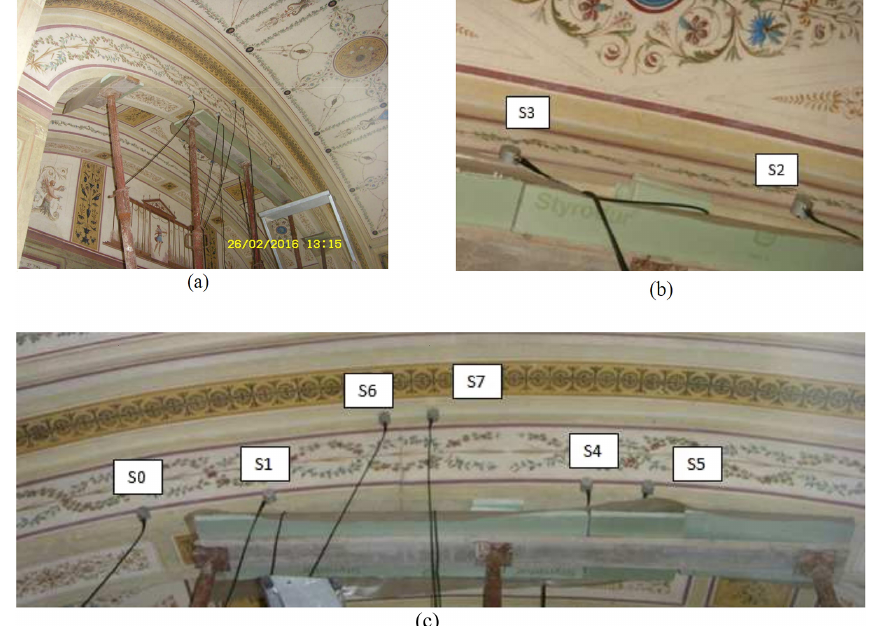
Figure 2. The monitored arch (a) and the transducers positions (b, c)